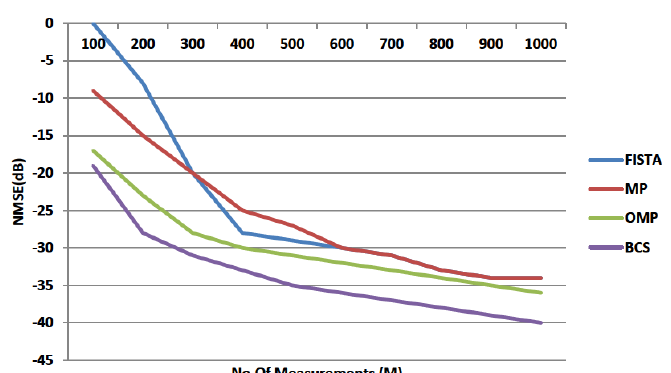
Figure 5: Comparison of